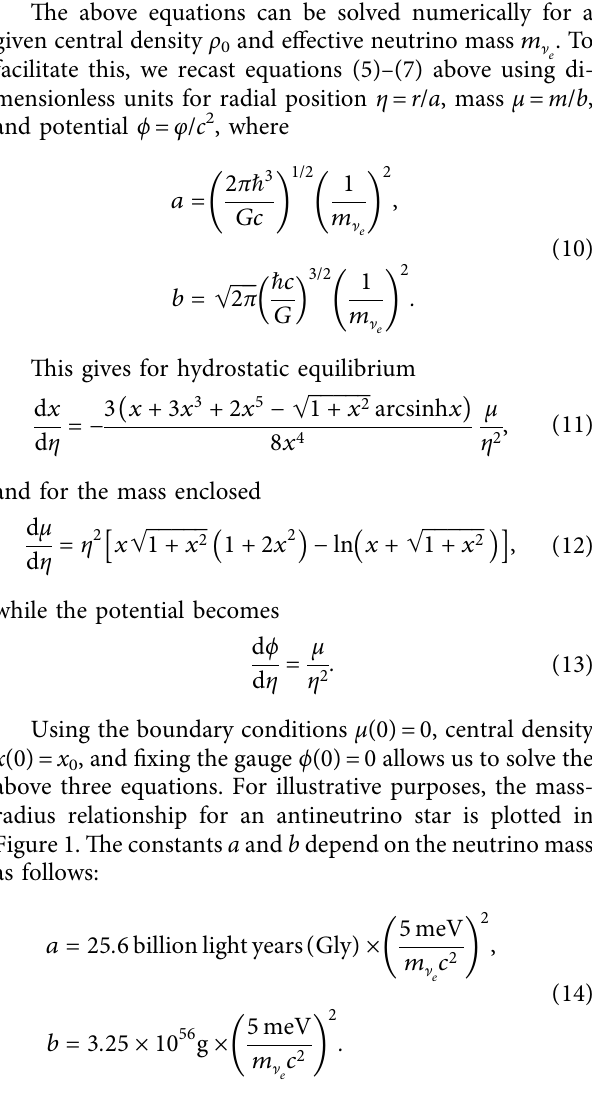
Figure 1: Mass-radius relationship for a neutrino star. The peak occurs at R / a � 1.06 and M / b � 0.356, which for neutrinos of mass m � 5 . 0meV/c 2 corresponds to R � 27 billion lightyears (Gly) and ] e M � 1.16 × 10 56 g. At smaller radii, the mass-radius curve corre- sponds to unstable configurations. Therefore neutrino stars may be relevant for